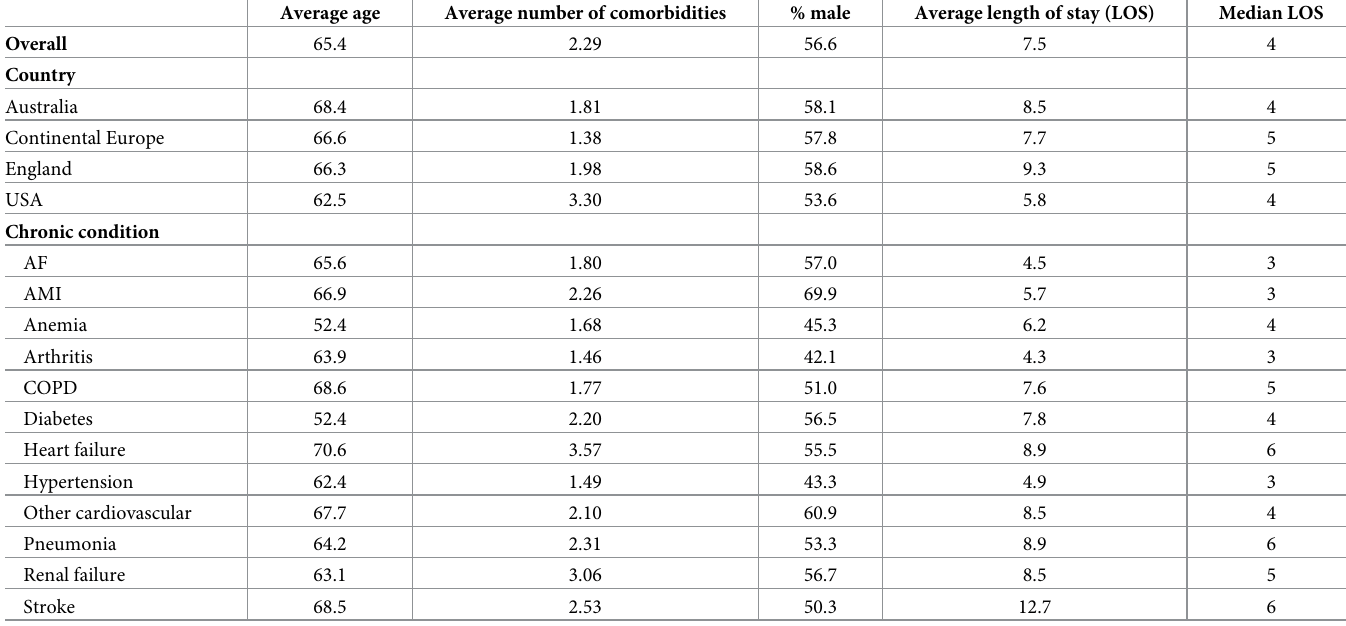
Table 1. Patient